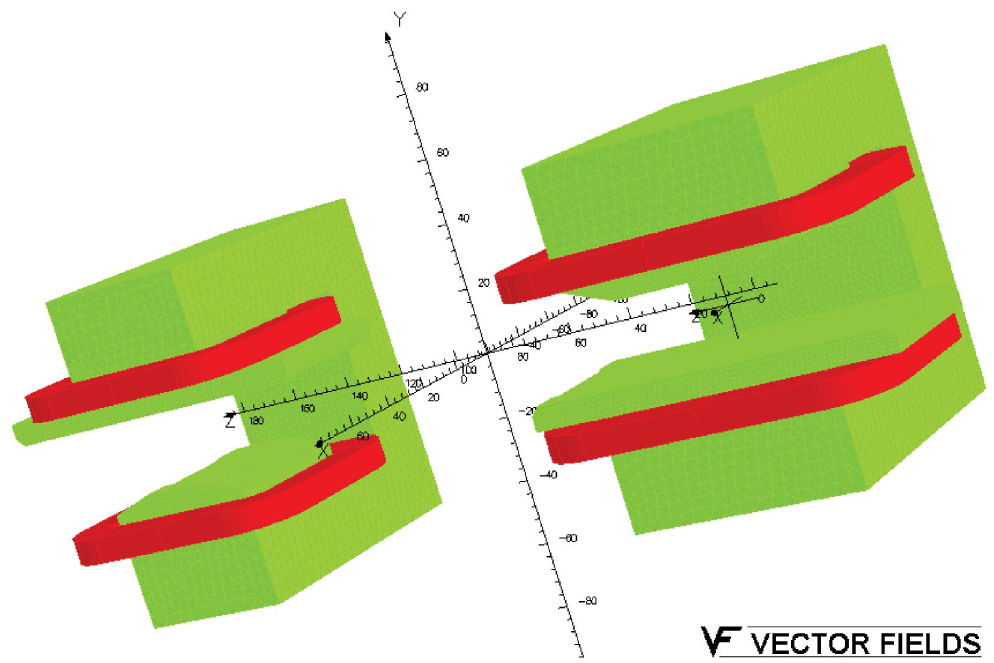
FIG. 2. (Color) D2 (right) and D3 simulation model.